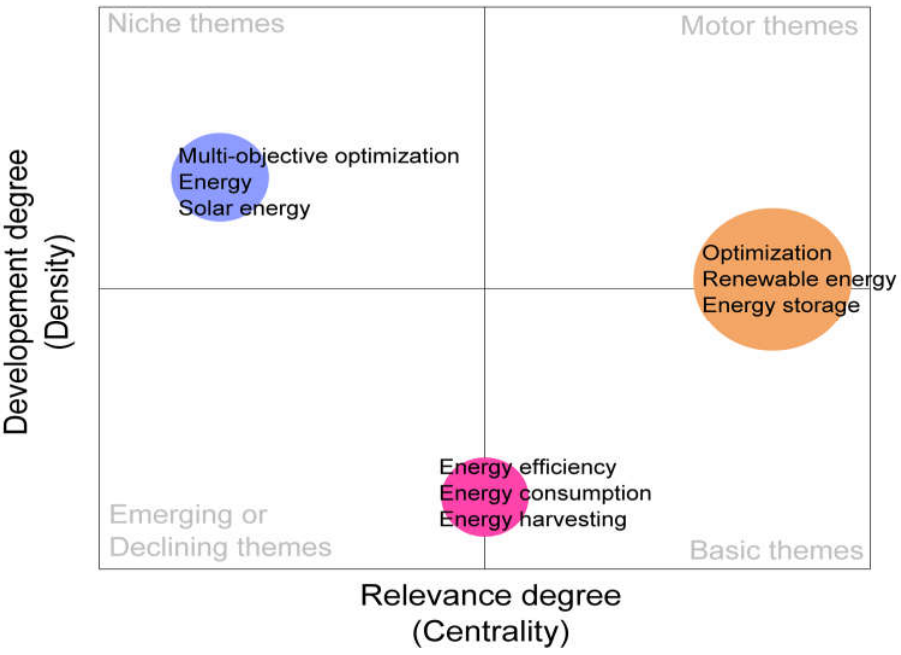
Figure 13. Thematic map of keywords.